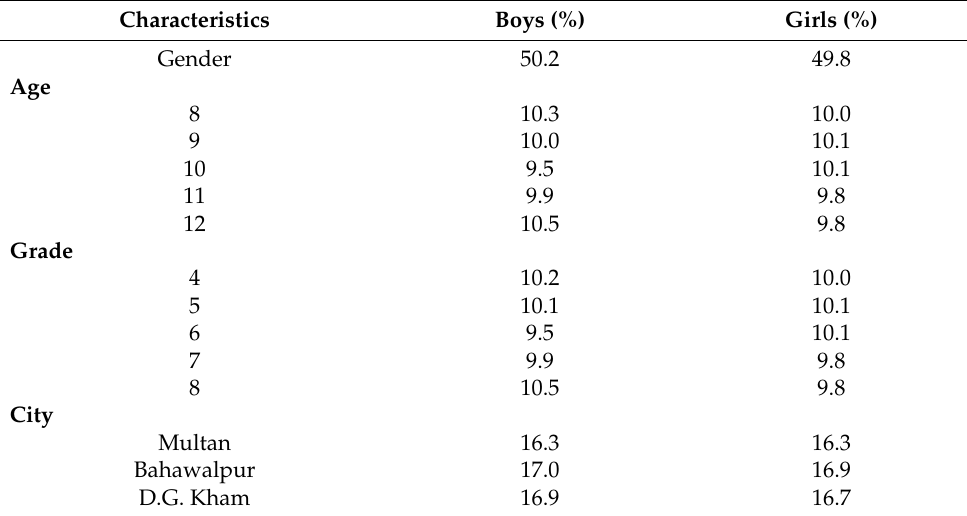
Table 1. Descriptive characteristics of the study population.